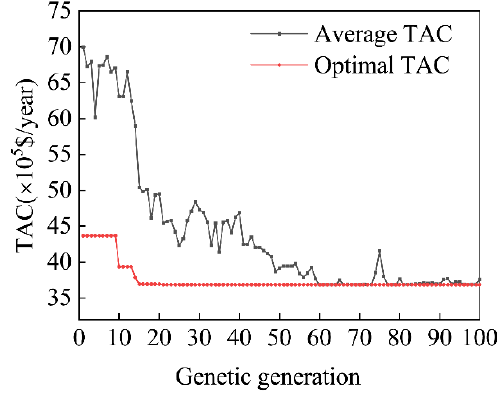
Figure 4. The running process of the algorithm.